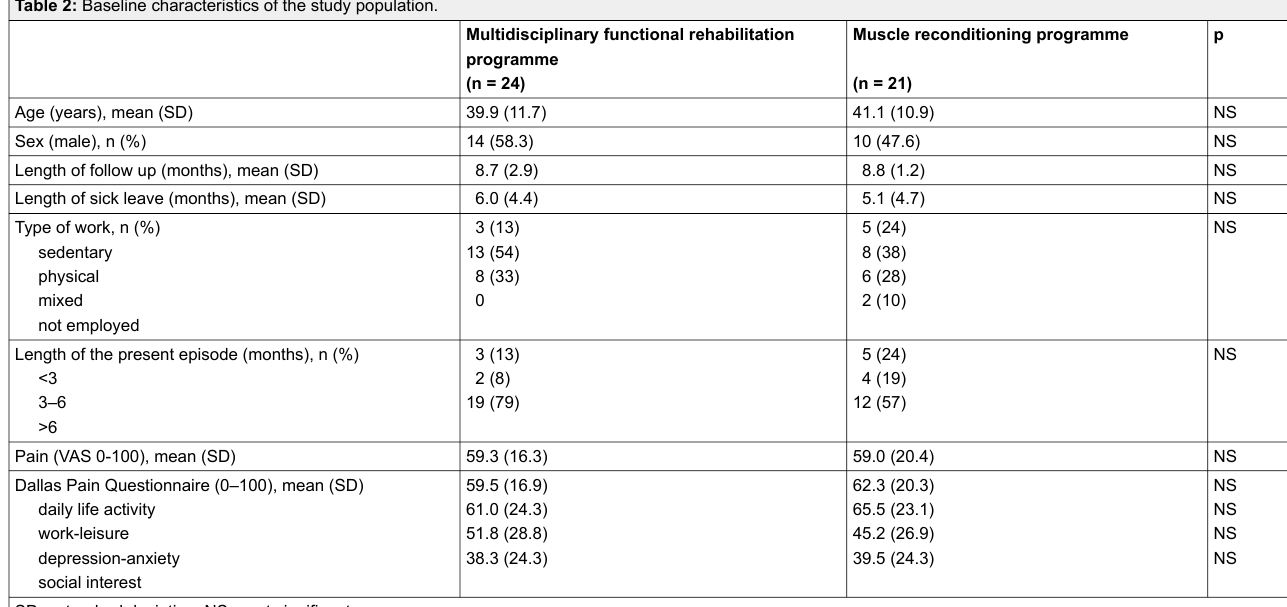
Table 2: Baseline characteristics of the study population.